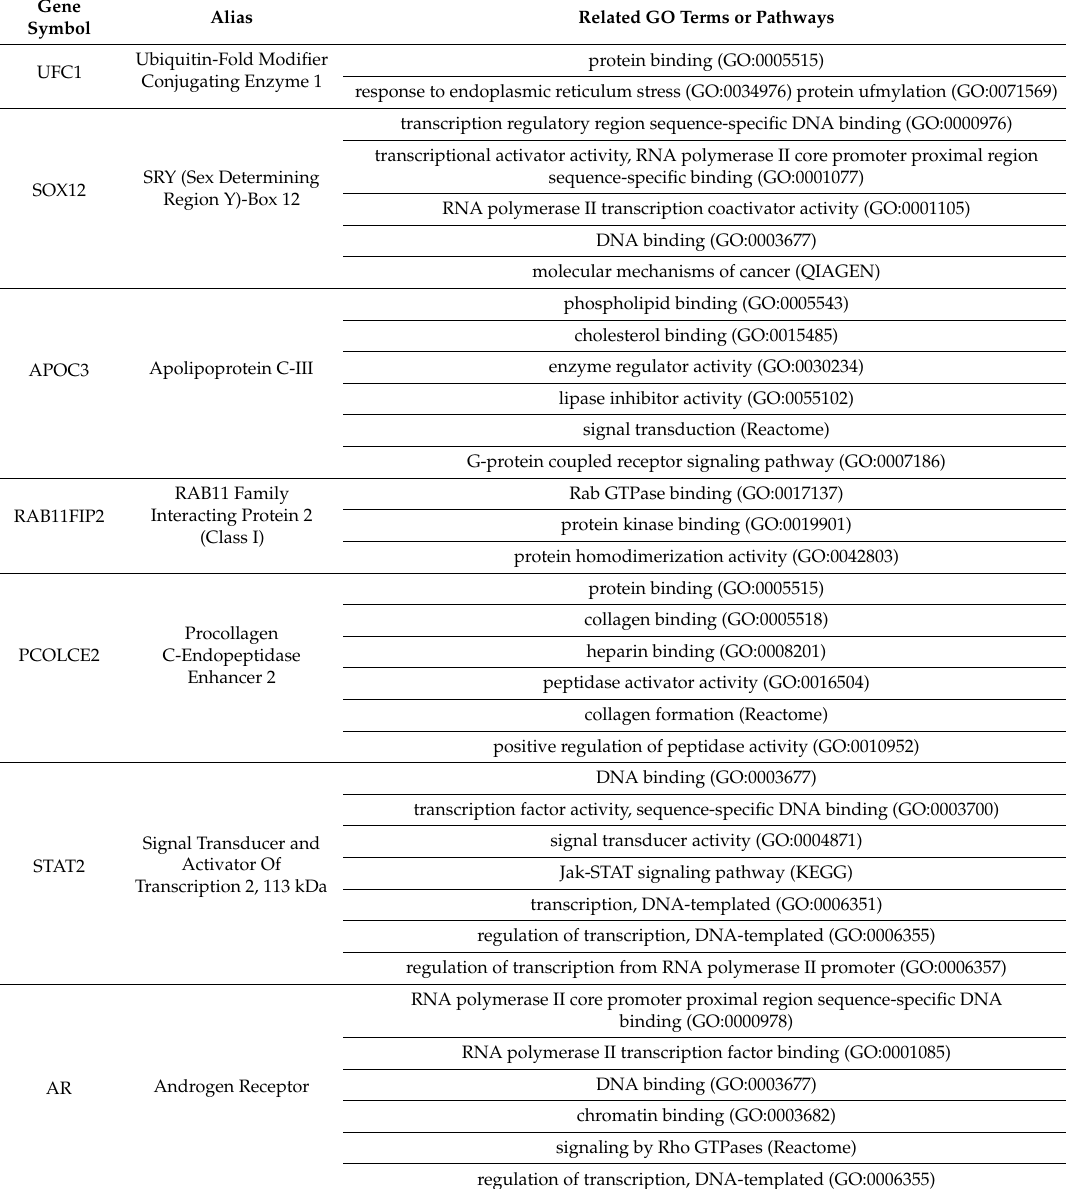
Table 7. Top 20 progressively deregulated genes from stage I to